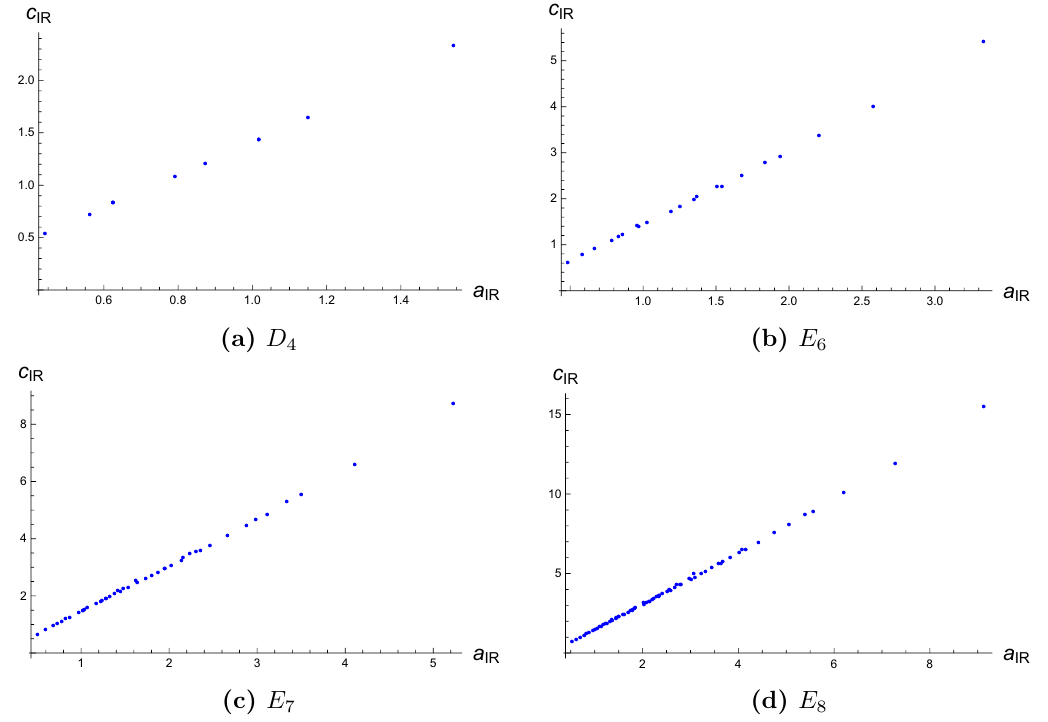
Figure 7. Plots of c IR vs. a IR for the di(cid:11)erent (cid:13)ipper (cid:12)eld deformations of probe D3-brane theories. the mean value of a =c decreases as we increase to larger (cid:13)avor symmetries. Precisely IR IR the opposite behavior is observed in the nilpotent networks of 4D conformal matter. See table 4 for the speci(cid:12)c